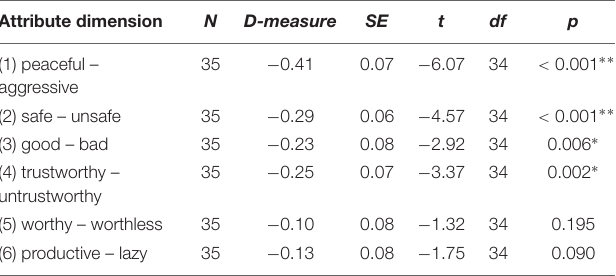
TABLE 5 | Mean D -measures, standard error ( SE ), and t -test statistics of all six IATs. Attribute dimension